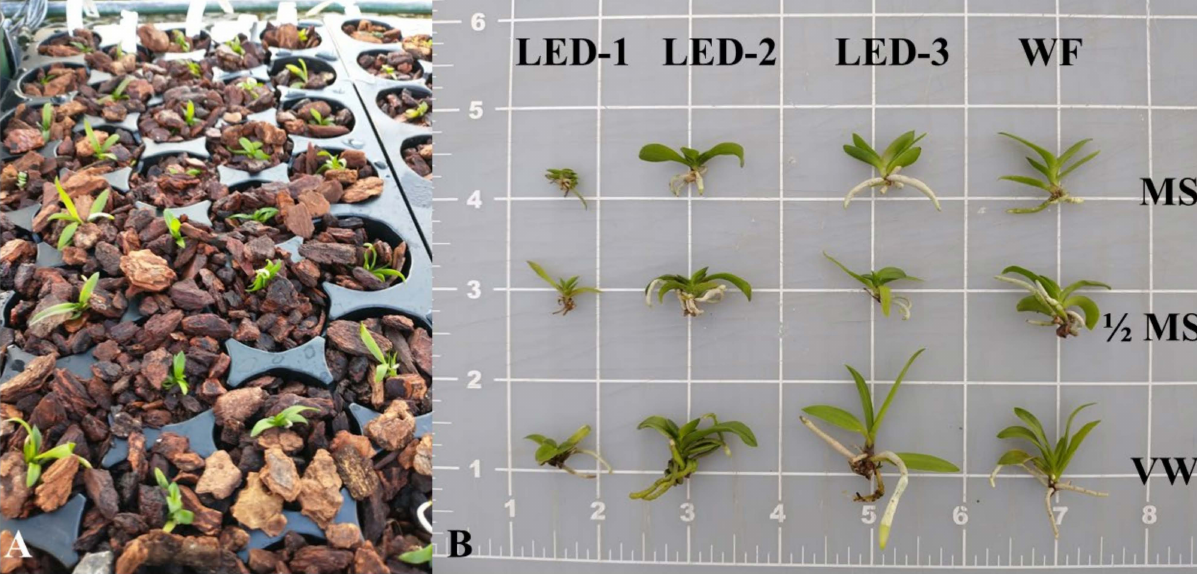
Figure 6. Effects of light sources and culture media on ex vitro plant survival ( A ) and plant per- formance ( B ) of B. nodosa during acclimatization for 30 days. LED-1: Light-emitting diode (LED) light with 1575 ± 50 µ mol m − 2 s − 1 Photosynthetic Photon Flux Density (PPFD); LED-2: LED light with 1015 ± 50 µ mol m − 2 s − 1 PPFD; LED-3: LED light with 80 ± 5 µ mol m − 2 s − 1 PPFD; and WF: white fluorescent light with 50 ± 5 µ mol m − 2 s − 1 PPFD. MS: MS basal medium supplemented with 30 g L − 1 sucrose and 7 g L − 1 agar; 1 / 2 MS: half-strength MS basal medium supplemented with 15 g L − 1 sucrose and 7 g L − 1 ; VW: VW basal medium supplemented with 10% coconut water, 20 g L − 1 sucrose and 7 g L − 1 . Scale bar = 1